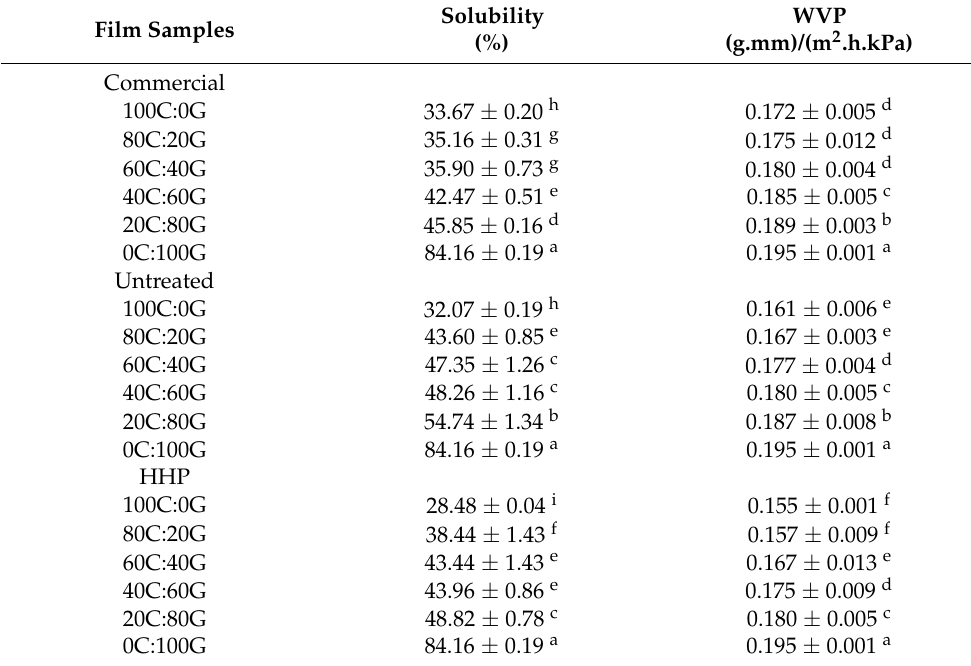
Table 2. Solubility and WVP of composite